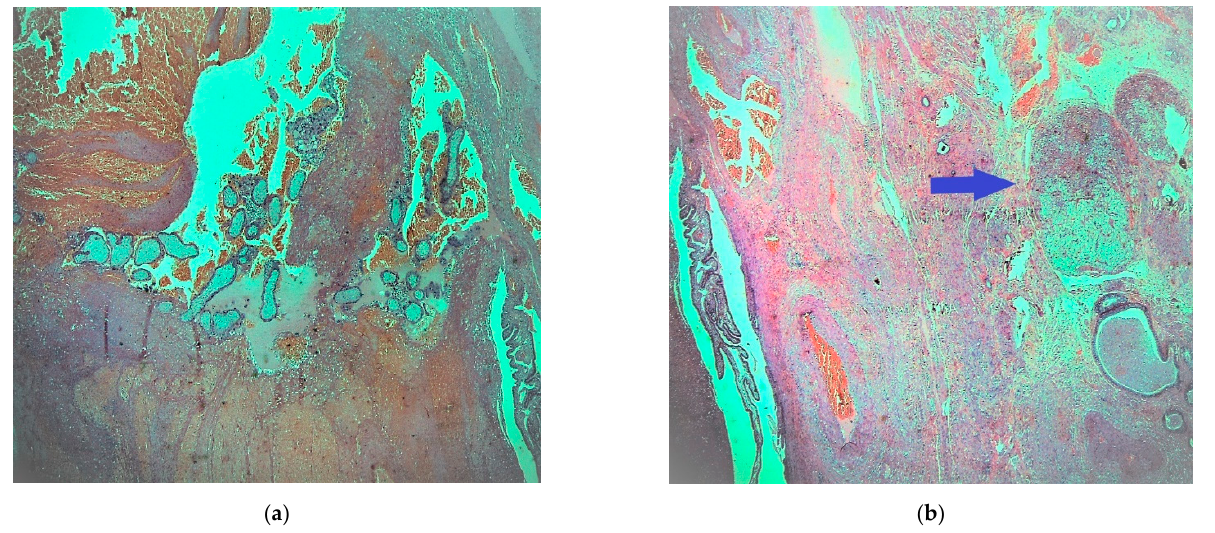
Figure 1. Fallopian tube: ( a ) fibrotic chorionic villi and trophoblast in the lumen of the salpinx (H & E, ×40); ( b ) demarcated nodule in the fallopian fibromuscular layer (blue arrow) (H & E, ×20).